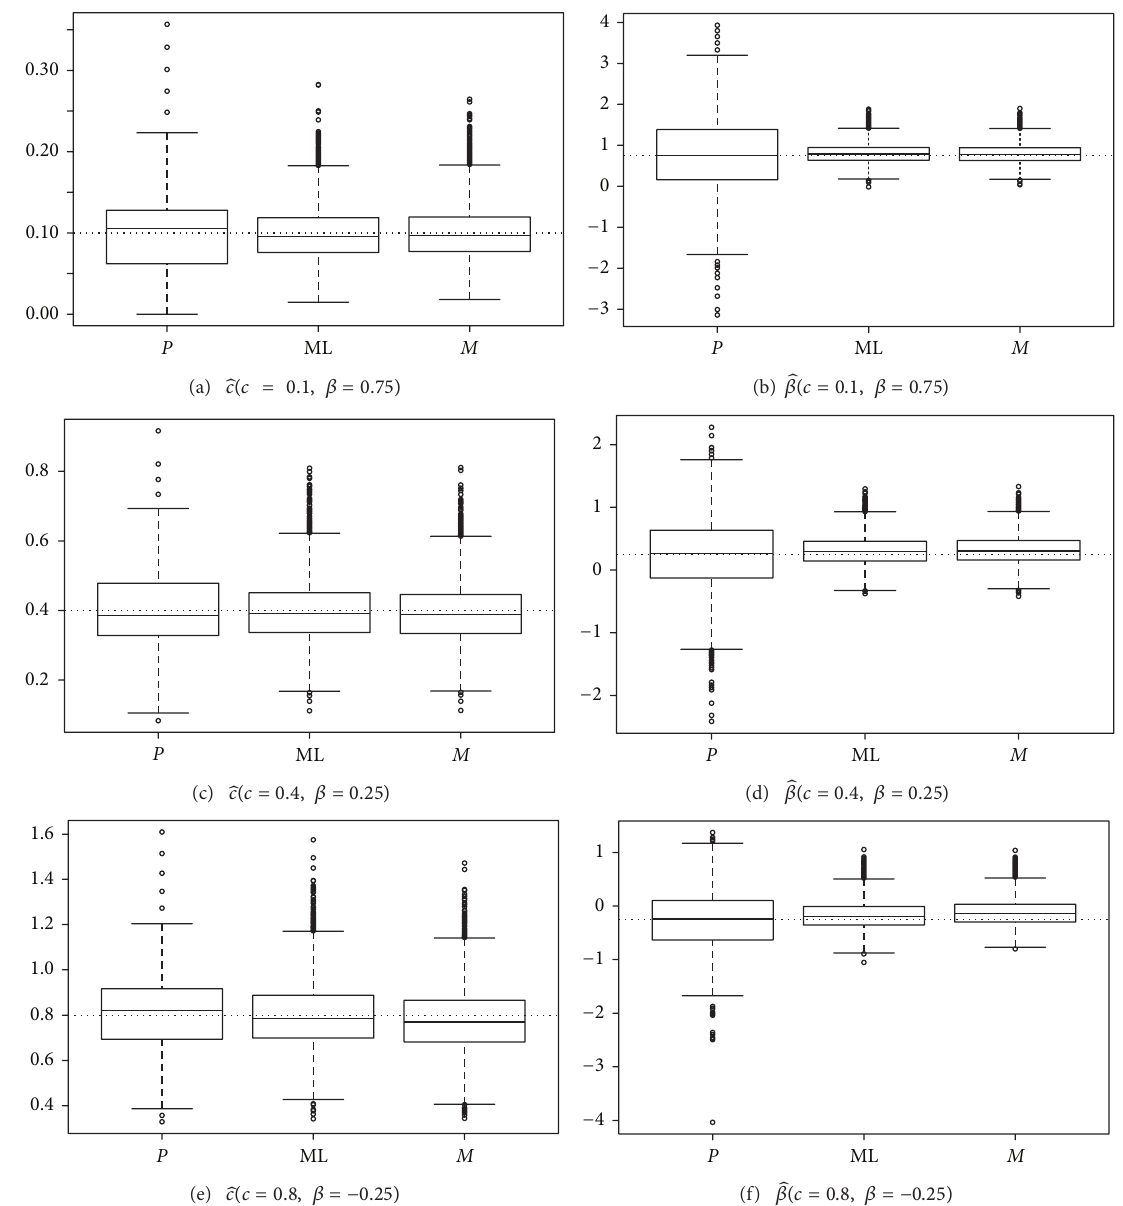
̂𝛽 for three parameter combinations ( 𝑛 = 50 and 5,000 MC runs). The dashed